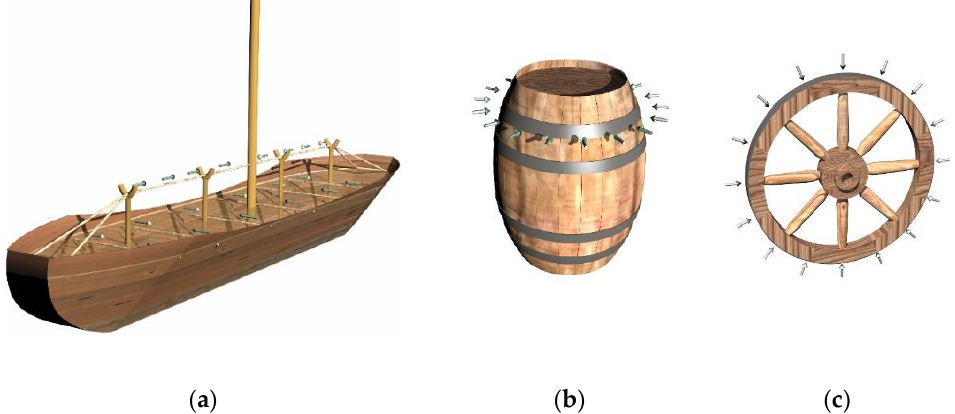
Figure 1. Application of the prestressing technique in different structures: ( a ) Ancient Egyptian prestressed ship; ( b ) prestressing used for barrels; ( c ) prestressed wheel.